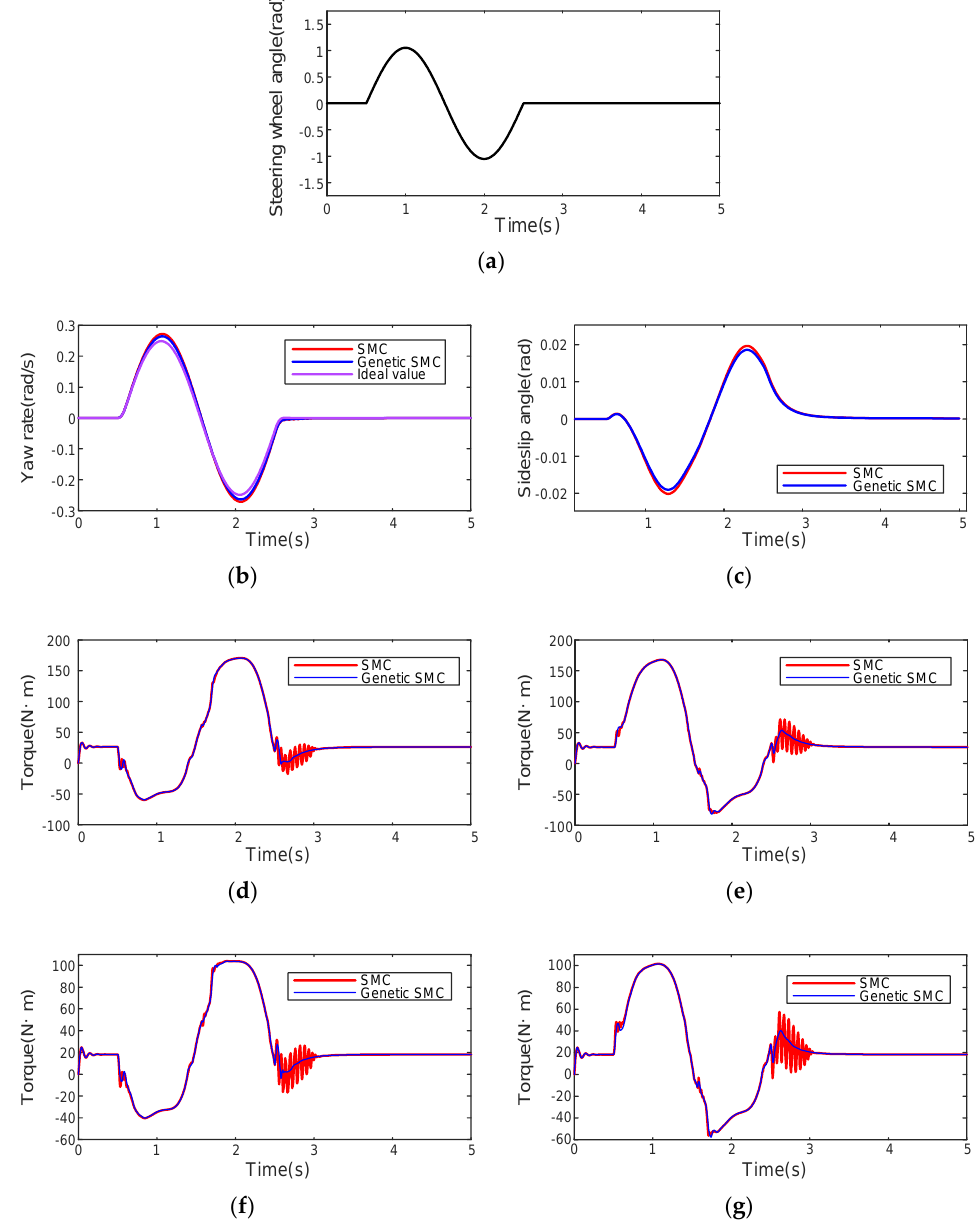
Figure 7. DYC controller on high tire – road friction coefficient road. ( a ) steering wheel angle; ( b ) yaw rate; ( c ) sideslip angle; ( d ) front left driving torque; ( e ) front right driving torque; ( f ) rear left driving torque; and ( g ) rear right driving torque.